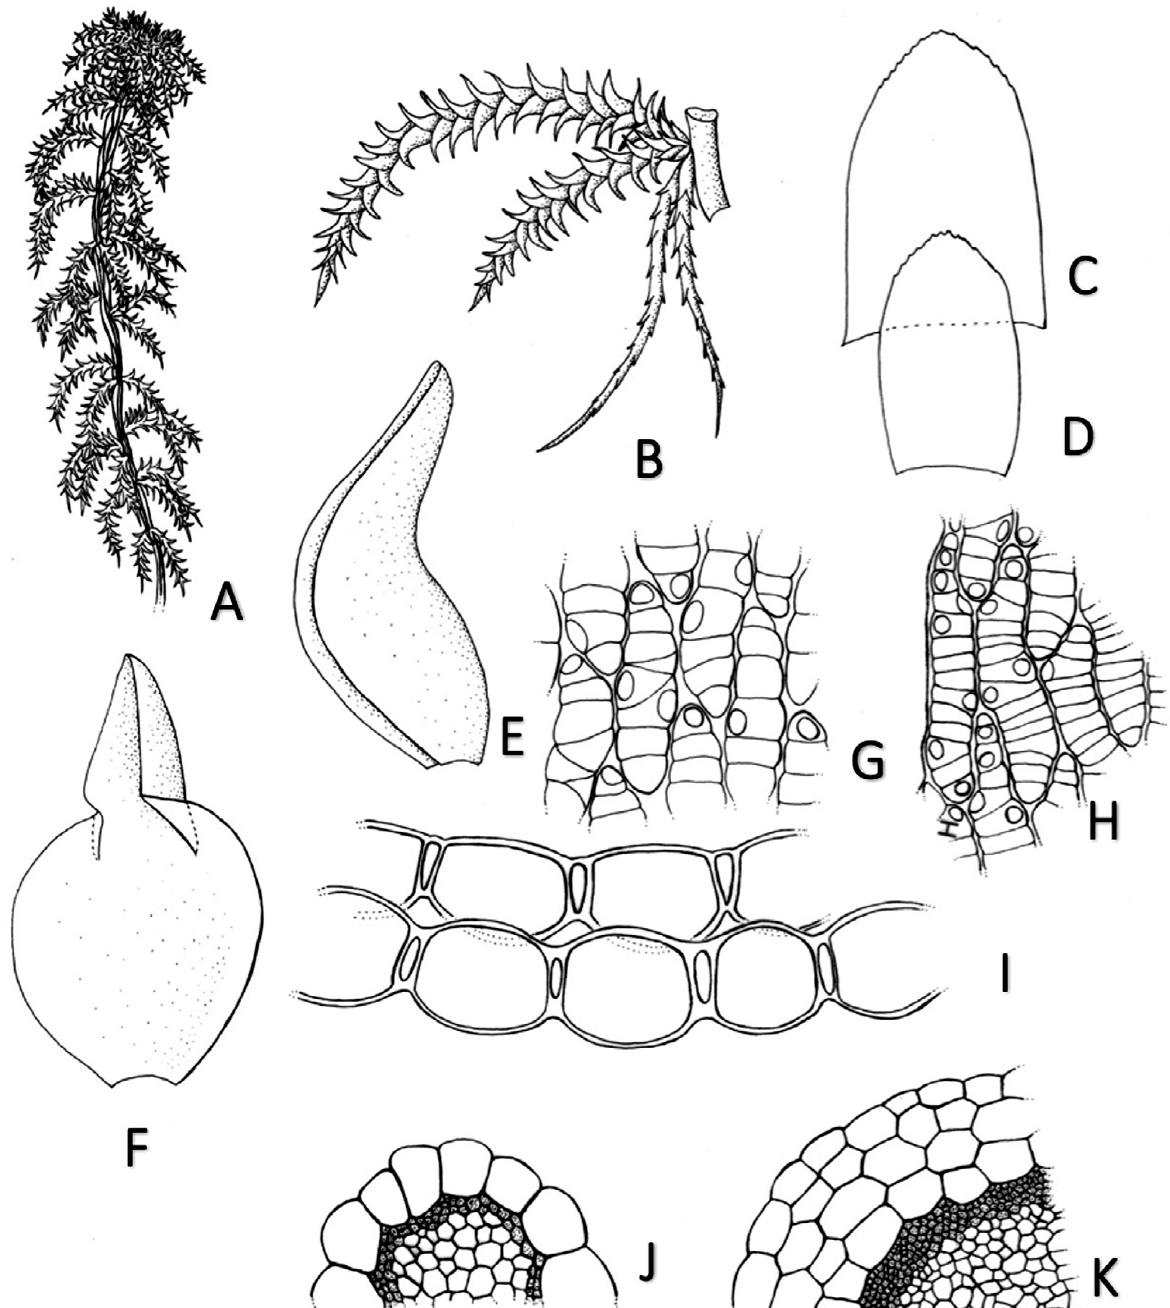
Figure 1. Sphagnum squarrosum Crome. A. Habit. B. Fascicle. C, D. Stem leaves. E, F. Branch leaves. G. Upper cells of branch leaf, outer surface. H. Upper cells of branch leaf, inner surface. I. Branch leaf in cross sections. J. Portion of branch in cross section. K. Portion of stem in cross section (A. Sehnem 334). Illustrations by Maria Alice de